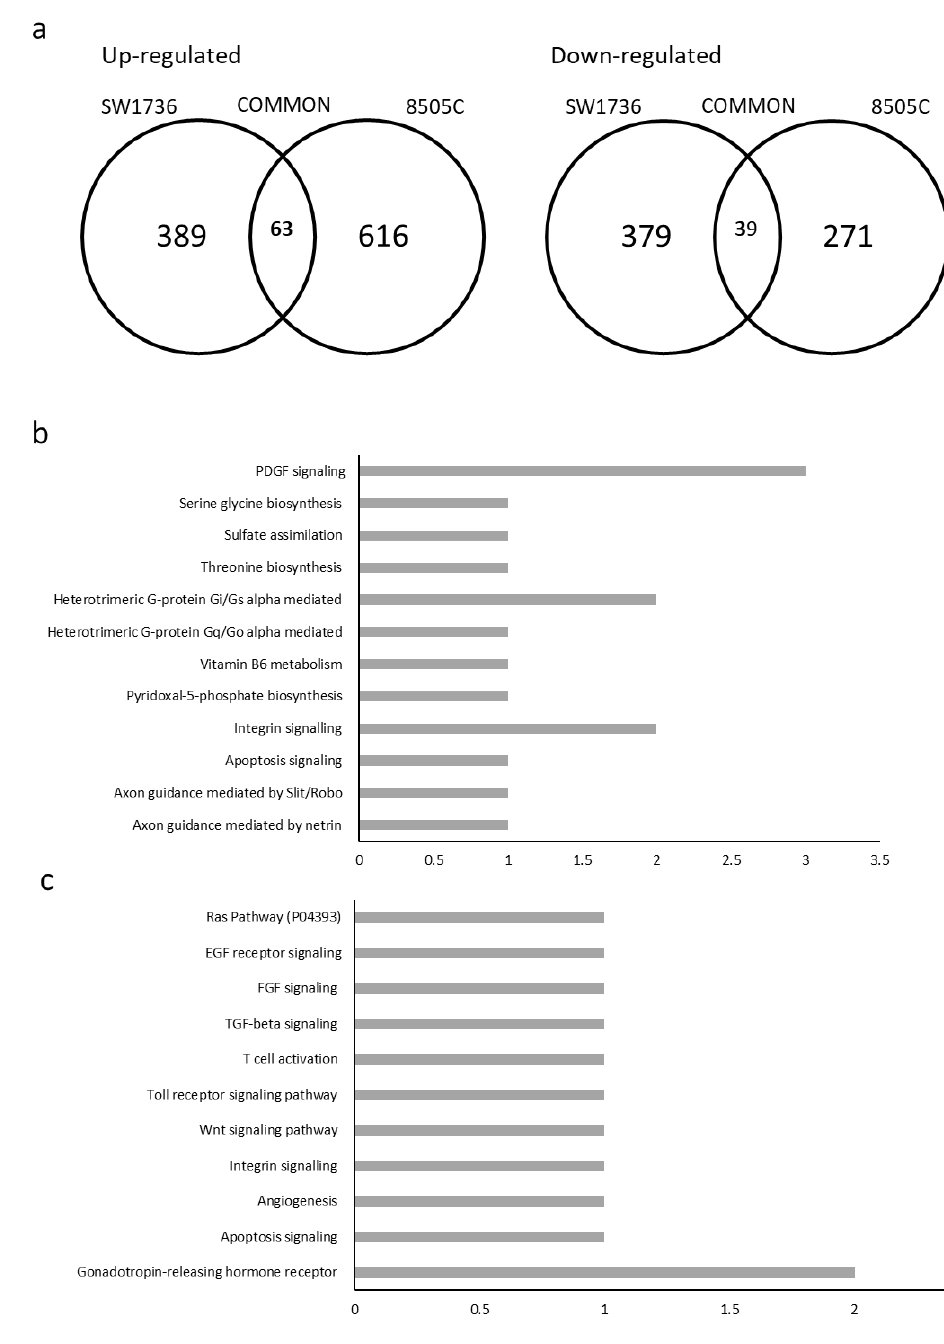
Figure 5. Pathway analysis after METTL3 silencing. ( a ) Number of genes up-regulated (left) or down-regulated (right) in each cell line or common between the two cell lines (intersection of the sets). List of pathways and the number of genes involved in each for up-regulated ( b ) and down-regulated ( c ) genes. The x-axis shows the number of genes involved in each pathway.